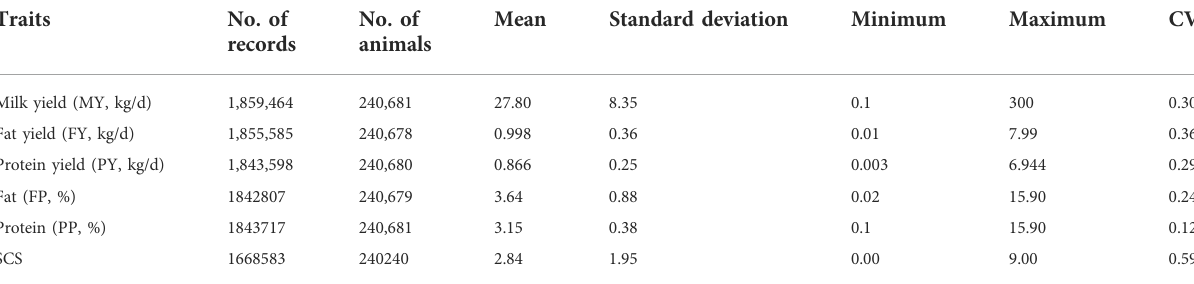
TABLE 1 Descriptive statistics of milk production and quality traits in Shanghai Holstein population.